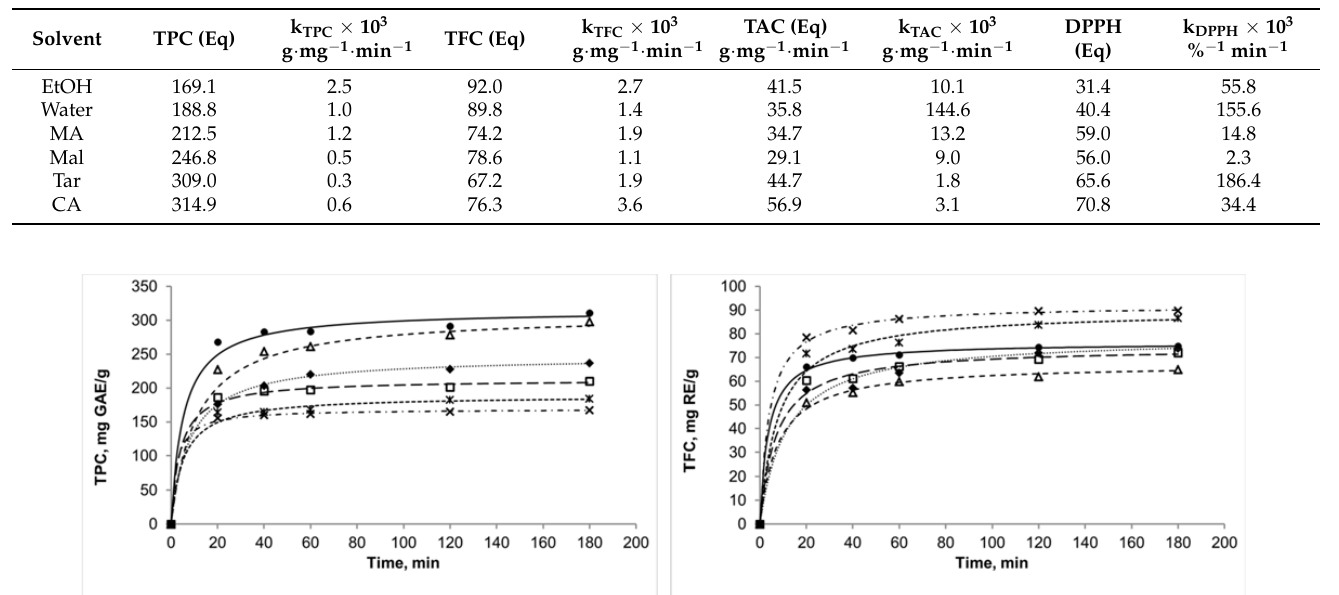
Table 2. Parameters of second-order kinetic model applied for TPC, TFC, TAC, and DPPH; “(Eq)” means “equilibrium values”; k: rate constant.